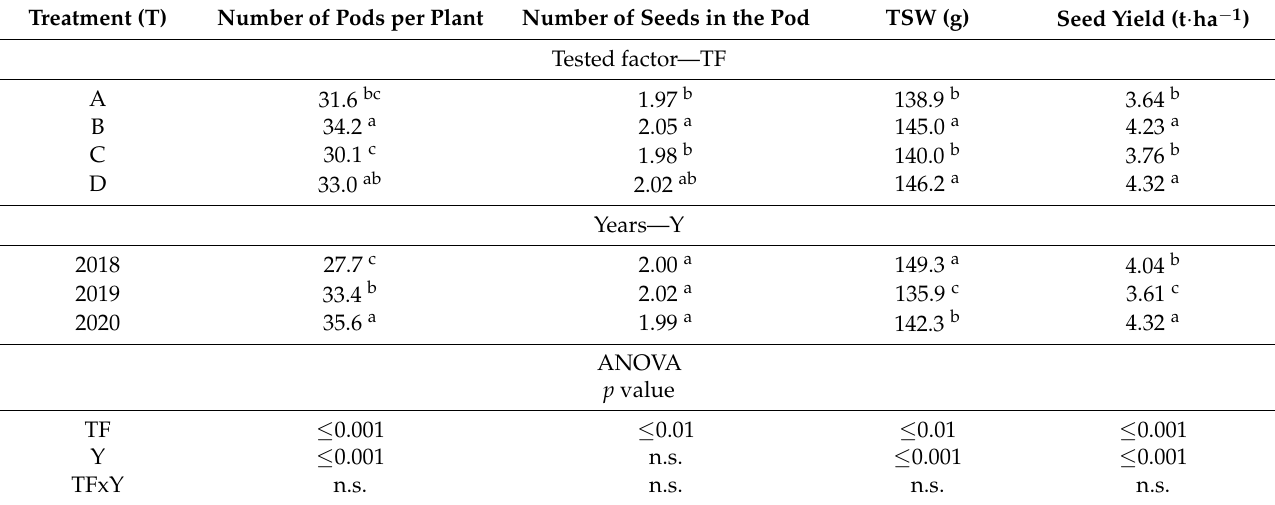
Table 4. Yield components and seed yield.